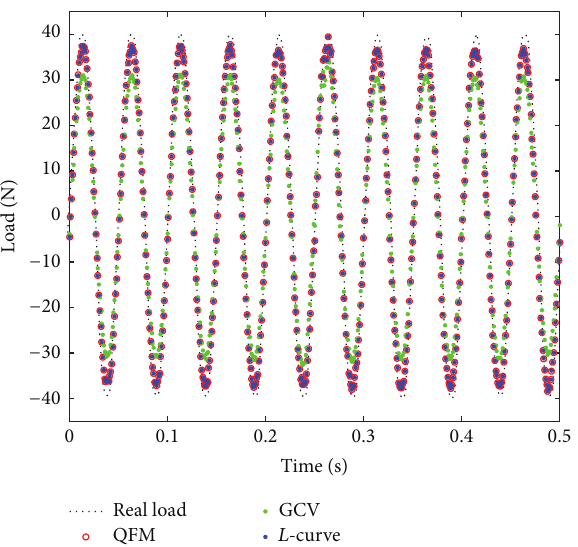
Figure 19: Results at different modeling error levels.